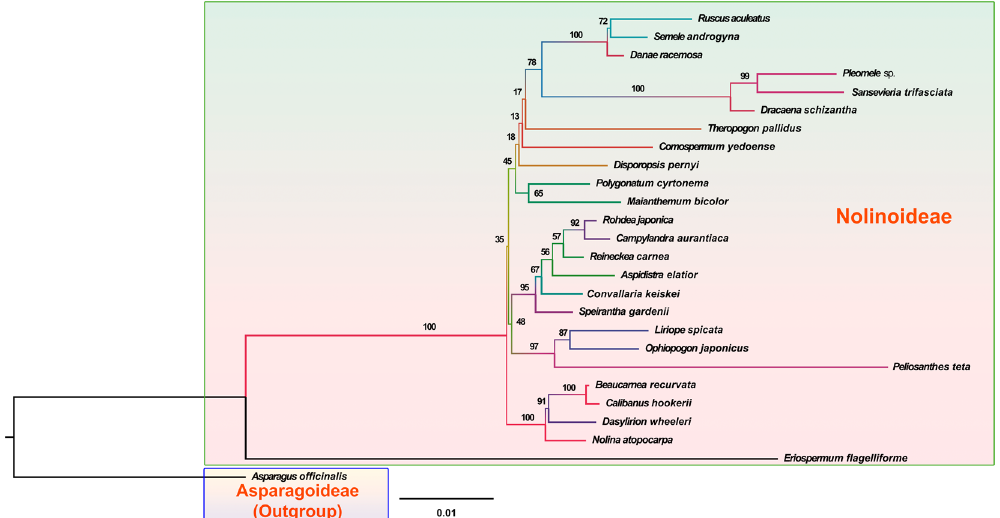
Figure 7. Molecular phylogenetic tree analysis of four chloroplast genes ( atpB , matK , ndhF and rbcL ) in the Nolinoideae subfamily. The tree was constructed by maximum likelihood analysis of the conserved regions using the RAxML program and the GTR + G + I nucleotide model. The stability of each tree node was tested by bootstrap analysis with 1,000 replicates. Bootstrap values are indicated on the branches, and the branch length reflects the estimated number of substitutions per 1,000 sites. Asparagus officinalis was set as the